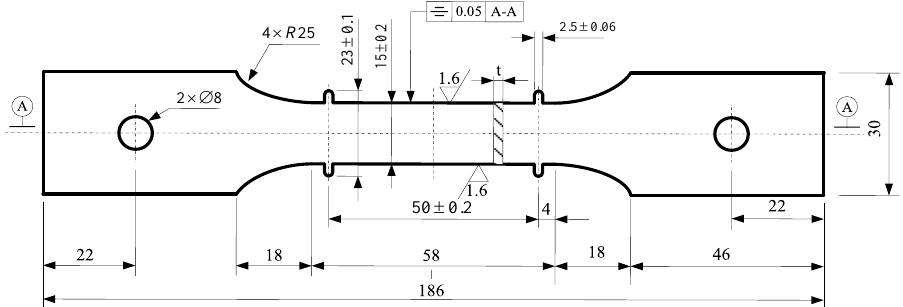
Figure 1. Drawing of creep age specimen adopted, in agreement with GB/T 2039-2012 (unit: mm).